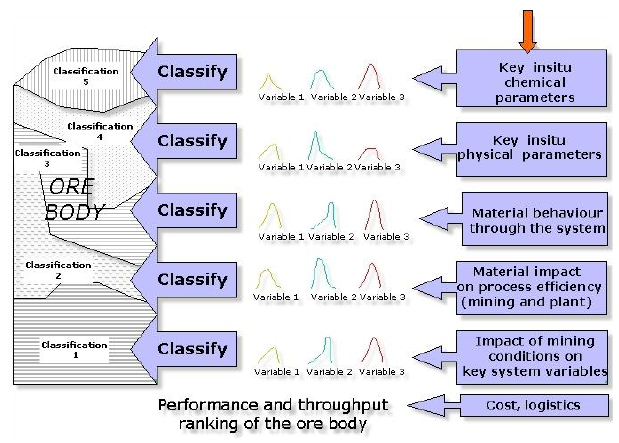
Figure 3: Factors considered in MRTM ranking and classification (domaining) of an ore body During the ranking and classification (domaining) exercise the key flow, PAY and cost drivers are determined per domain and transferred to an operational performance matrix. In Figure 4 an operational performance matrix for an underground mine depicting the dip and depth below surface of the ore body as the key performance drivers, is shown.